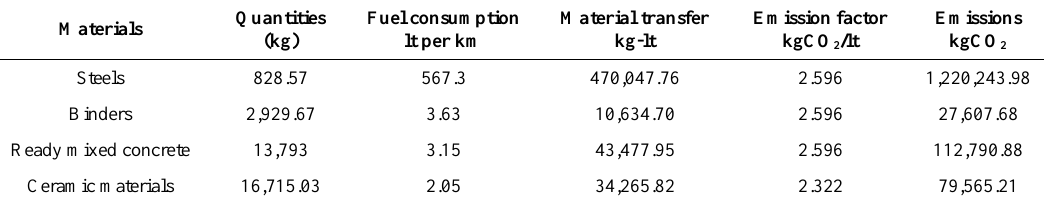
Table 1. CO 2 emissions from transfers of construction materials.